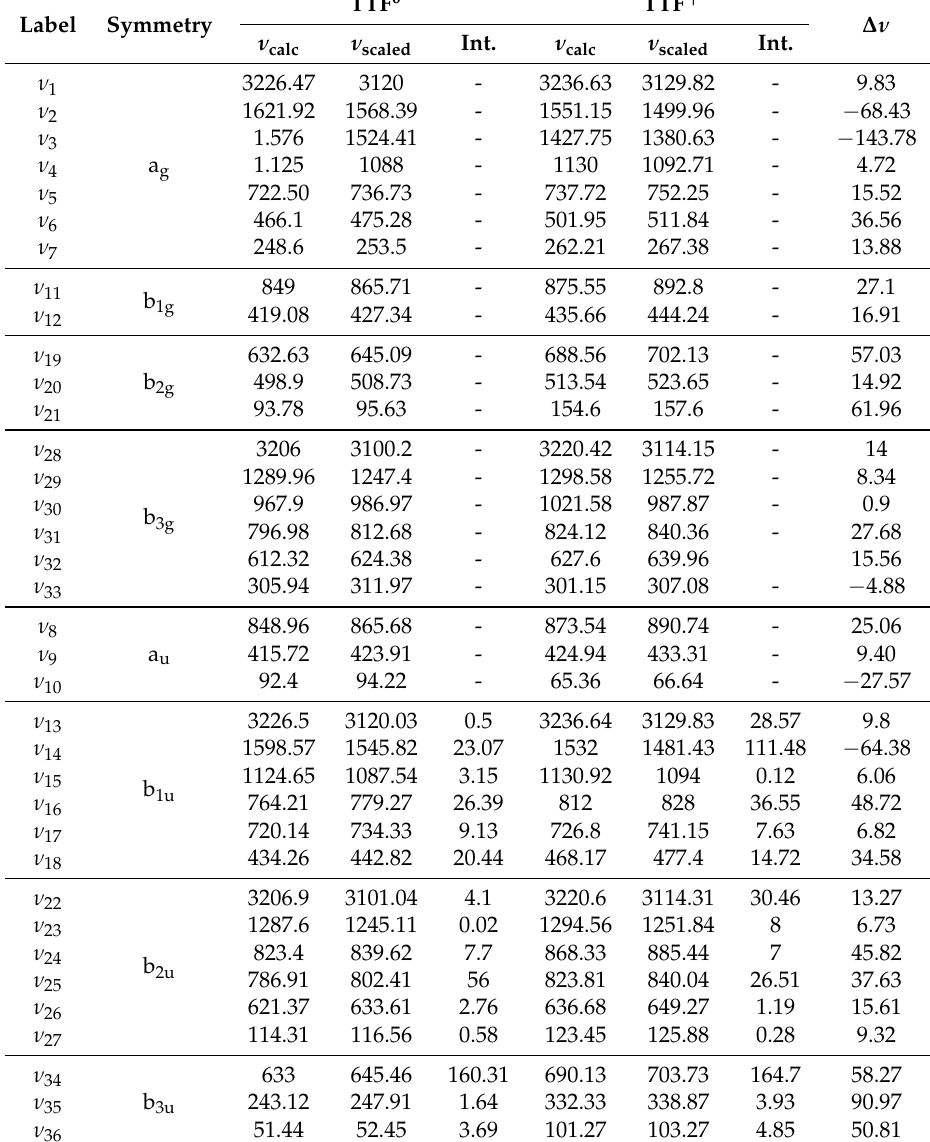
Table C2. Calculated frequencies (cm − 1 ) and infrared intensities (D 2 amu − 1 · Å − 2 ) of neutral TTF and inonized TTF +